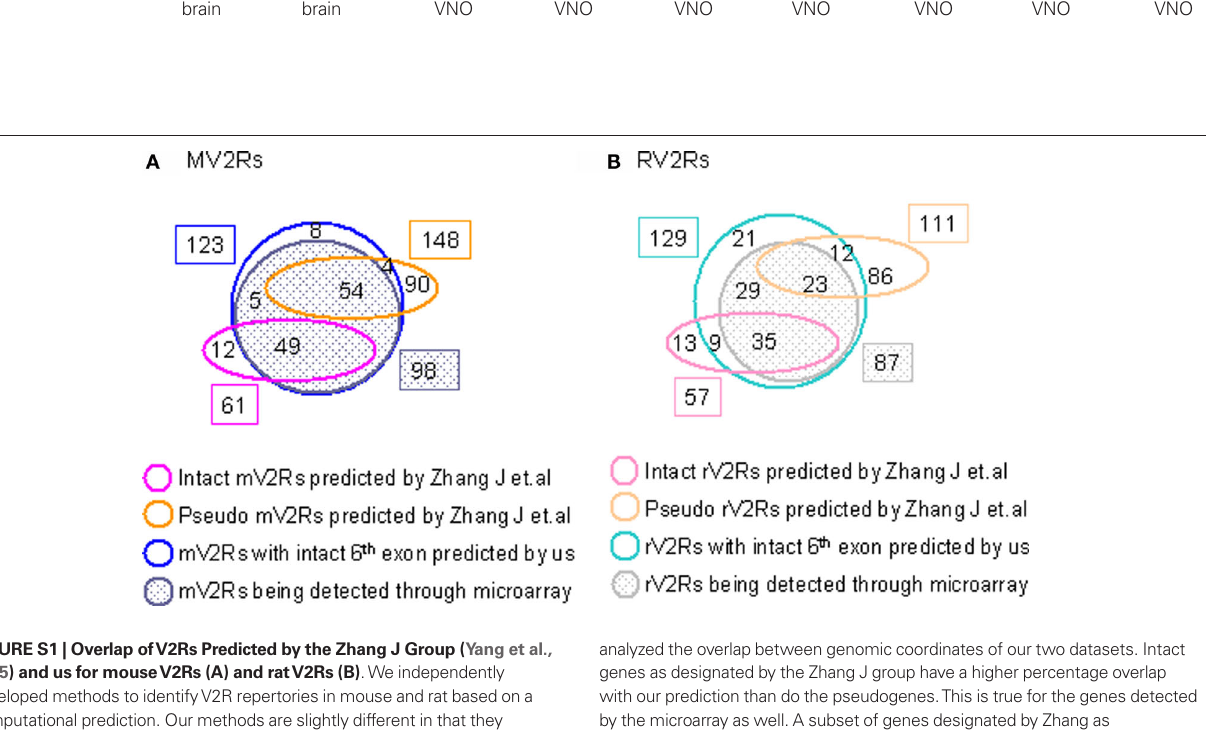
FiGuRe S1 | Overlap of V2Rs Predicted by the Zhang J Group (Yang et al., 2005) and us for mouse V2Rs (A) and rat V2Rs (B) . We